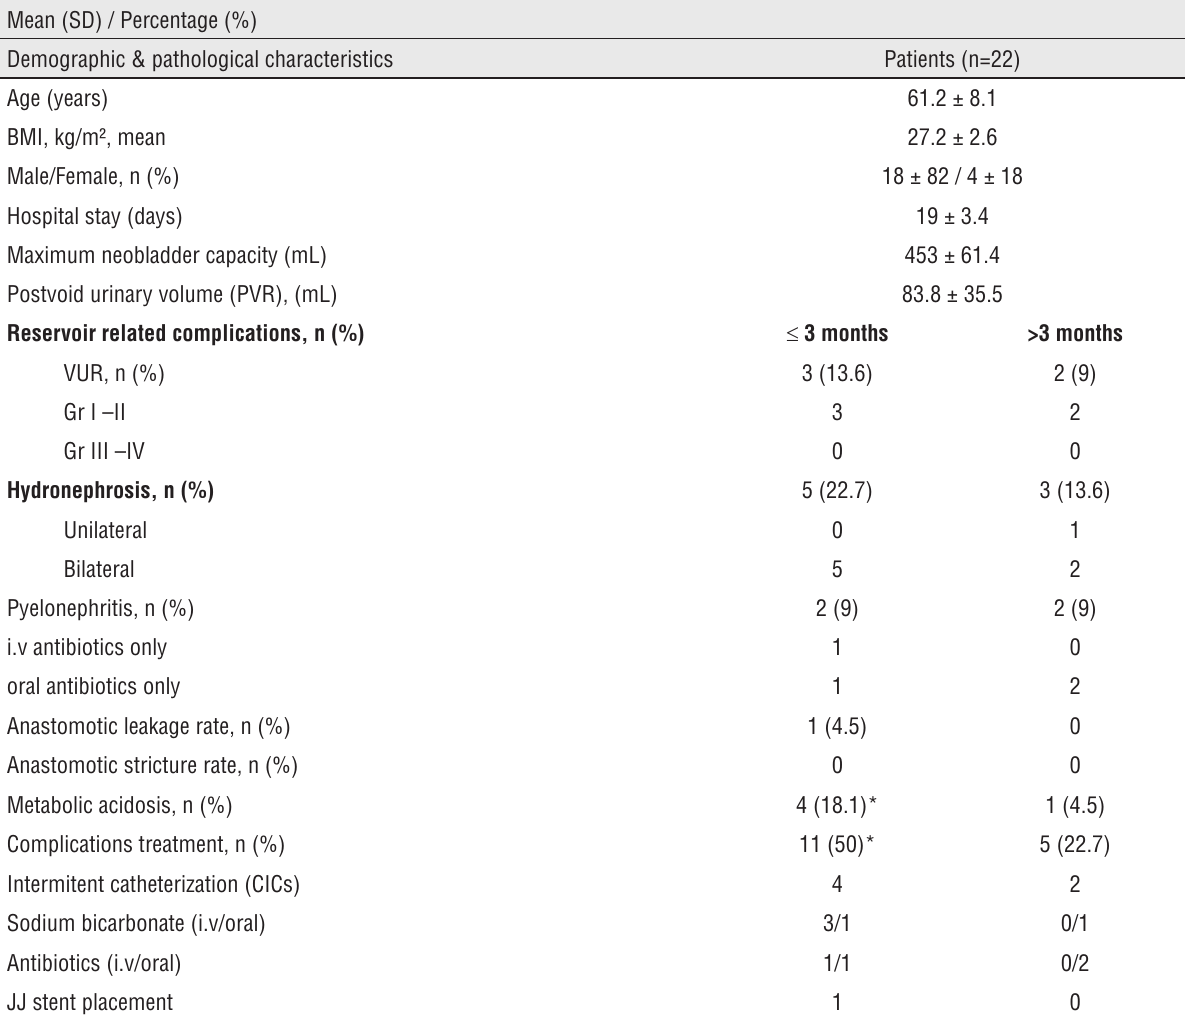
Table 1 - Clinicopathological features and perioperative outcomes with diversion-related complications within first three months and during follow-up after surgery with their